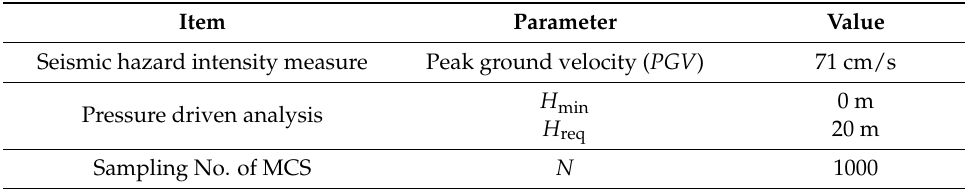
Table 4. Parameter setting of the seismic performance analysis model.